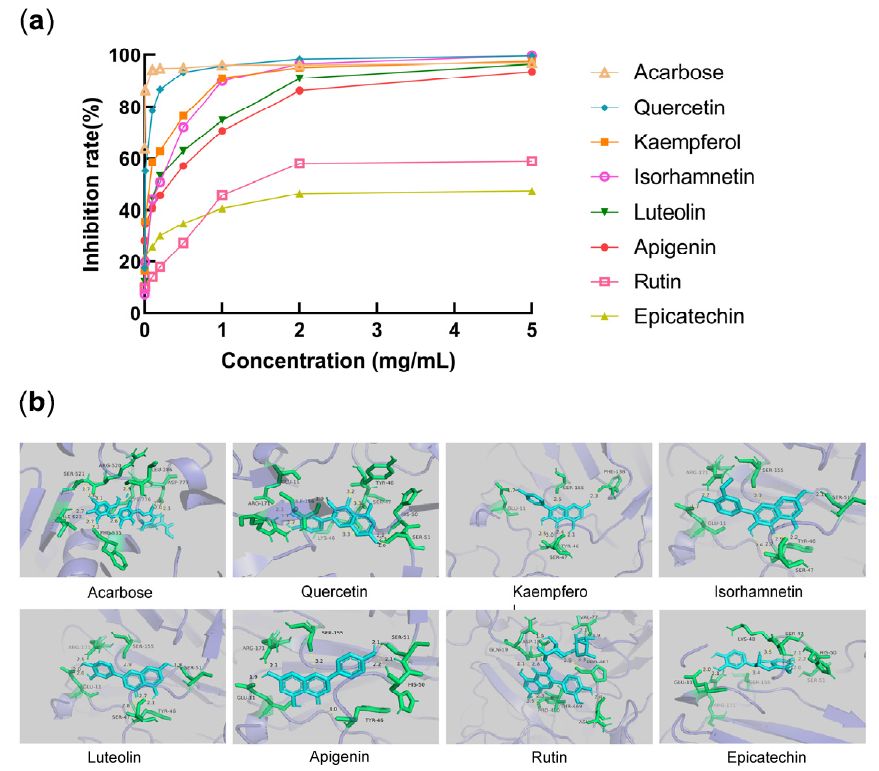
Figure 4. The date of flavonoids with α -glucosidase inhibition activity and molecular docking: ( a ) acarbose (positive control) and active constituents on α -glucosidase inhibition activity; ( b ) molecular docking analysis of acarbose (positive control) and active constituents. Table 3. IC50 values and molecular docking binding energies of 7 representative flavonoids.